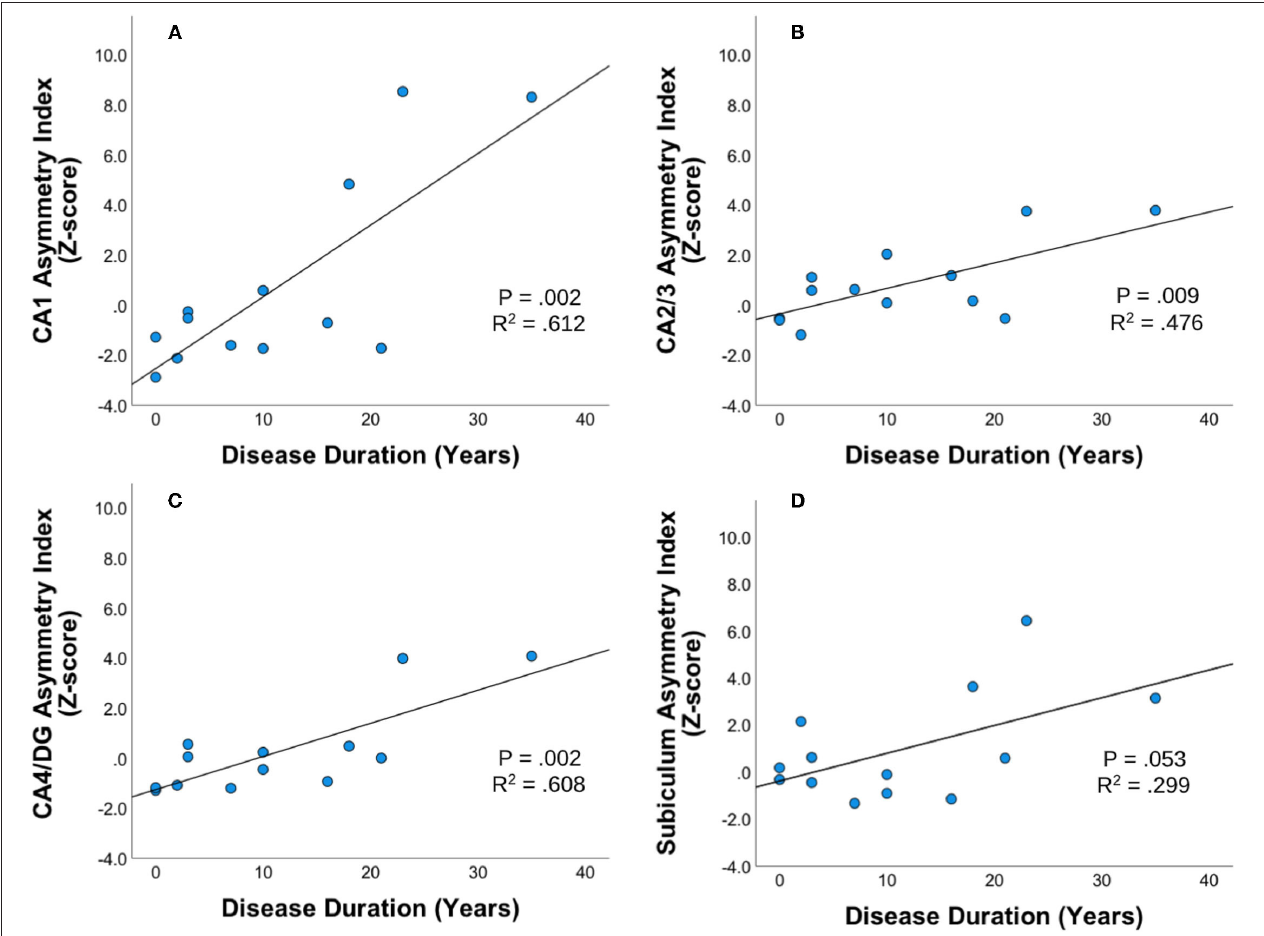
FIGURE 2 | Disease duration and subfield asymmetry. Strength and direction of association between disease duration and asymmetric index Z-scores across hippocampal subfields (A) CA1, (B) CA23, (C) CA4DG, and (D) Subiculum for patients with unilateral mTLE (mesial temporal lobe epilepsy). Pearson’s two-tailed correlations were completed. Correlation was significant if p <